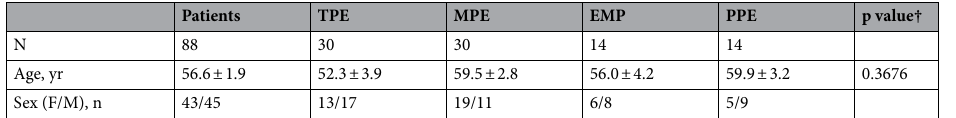
Table 1. Demographic data of the study population. Values are presented as mean ± standard error of the mean (SEM). TPE tuberculous pleural effusion, MPE malignant pleural effusion, EMP Empyema, PPE parapneumonic. † Comparisons of data between TPE, MPE, EMP and PPE effusions were performed using one-way analysis of